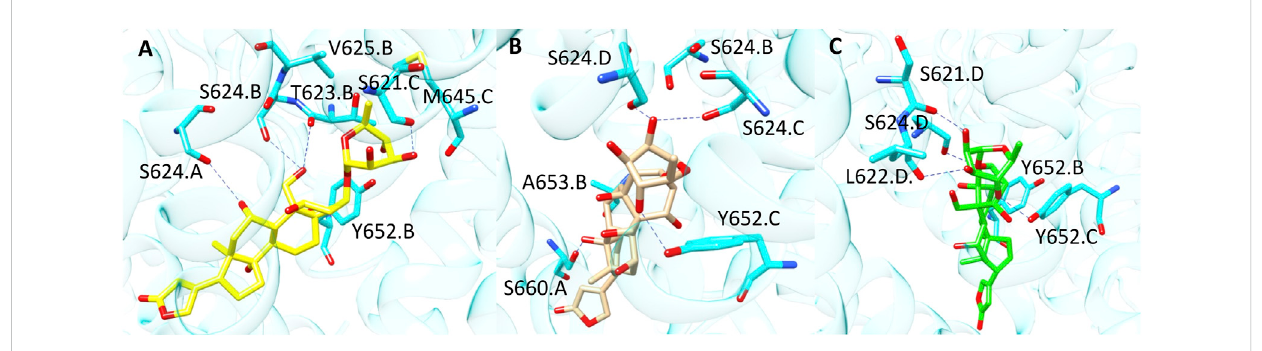
FIGURE 5 Binding modes of compound 7 into hERG binding site predicted by (A) PLANTS, (B) LiGen and (C) GOLD. H-bonds are represented as blue dashed lines.